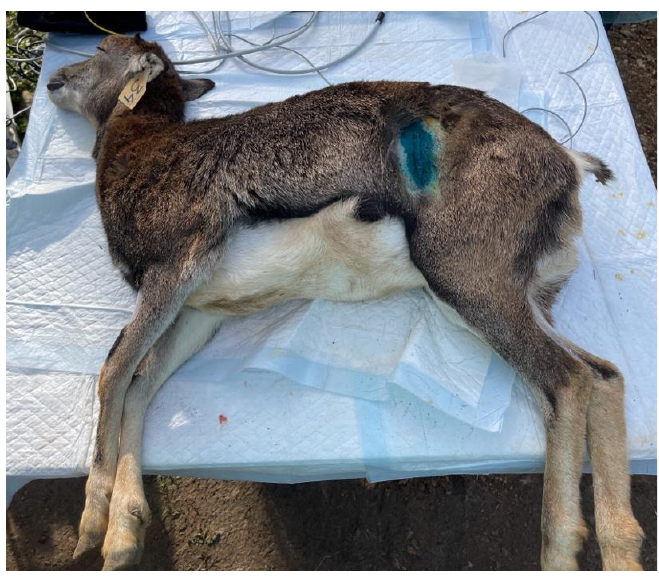
Figure 2. Area where the incision for left flank ovariectomy was made.